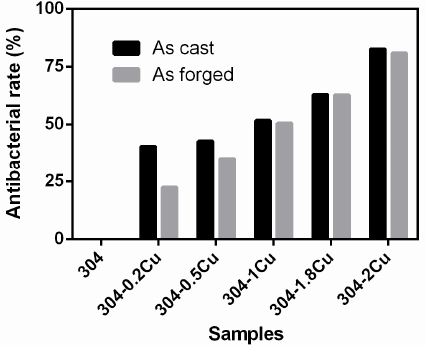
Figure 2. Colonization of E. coli after 24 h coculture with a change in Cu content.